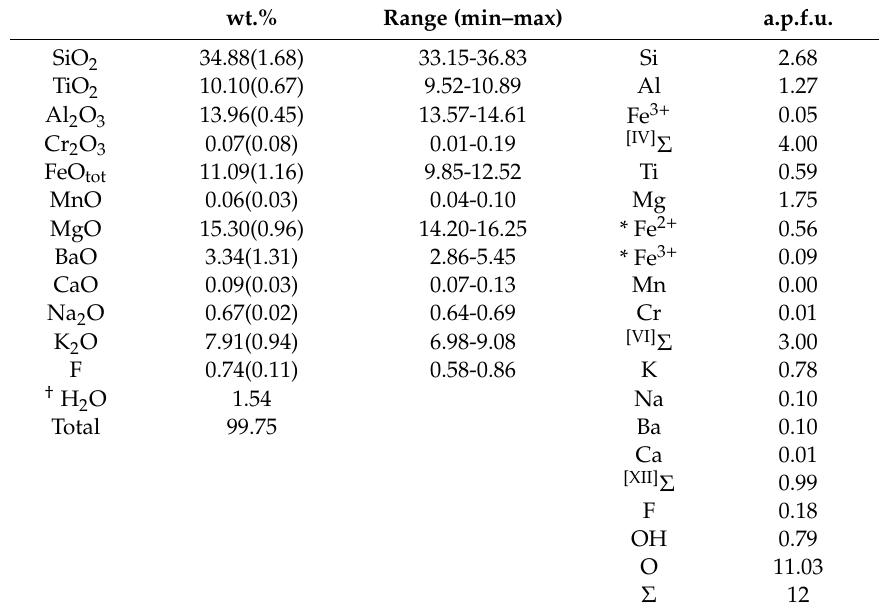
Table 4. Average chemical composition and structural formula (apfu) of the barian titanian phlogopite investigated by single-crystal X-ray di ff raction (SCXRD). Standard deviation in